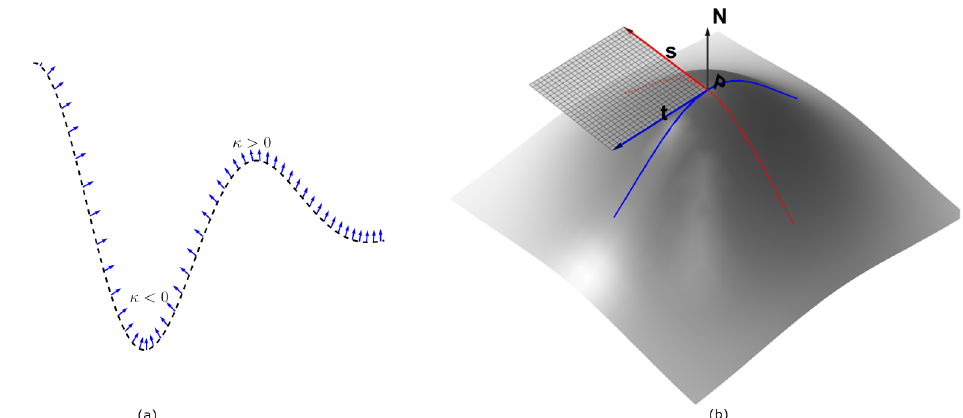
Figure 1. In panel ( a ), a parametric curve in R is shown with the normals at sampled points. The region where the normals are converging has negative curvature, while the opposite is true for where the normals diverge. In panel ( b ), a parametric surface is depicted, with the two principal directions s (= X u ) and t (= X v ) at the point P . A portion of the tangent plane to the surface at the point P is also shown in transparent grid, as determined by s and t , and the corresponding normal N = indicated up arrow. The principal directions correspond with the maximum and minimum curvature directions on the surface. All of these images are better visualized in color.